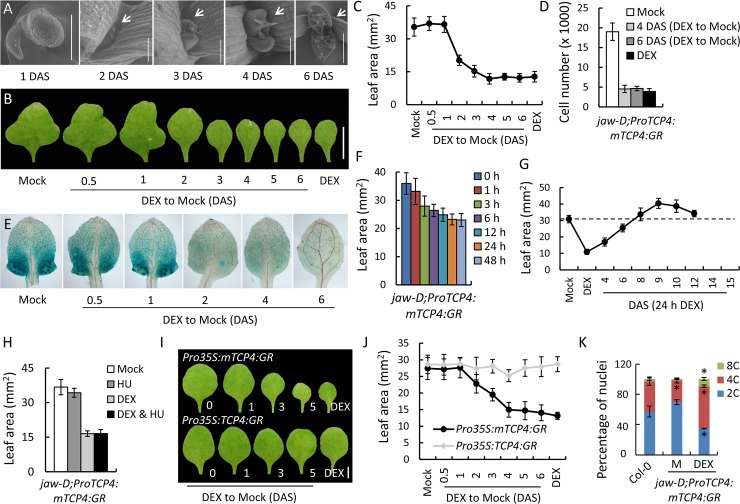
TCP4 irreversibly commits the proliferating cells of leaf primordia to differentiation.(A) Scanning electron micrographs of jaw-D;ProTCP4:mTCP4:GR seedlings after indicated DAS. A germinated seed (1 DAS) and the meristematic region of seedlings are shown. Scale bars, 500 μm (1, 6 DAS) and 100 μm (2, 3, 4 DAS). (B) Mature first leaf (29 DAS) of jaw-D;ProTCP4:mTCP4:GR seedlings grown in the presence of 12 μM dexamethasone for the indicated DAS and then shifted to medium without dexamethasone. Leaves grown in continuous absence (Mock) or presence (DEX) of dexamethasone are shown as controls. Scale bar, 5 mm. (C) Average size of leaves shown in (B). N, 12–15 leaves. (D) Number of pavement cells in leaves shown in (B). (E) GUS reporter analysis of first leaf from 8-day old jaw-D;ProTCP4:mTCP4:GR X ProCyclinD3;2:GUS seedlings grown in the presence of dexamethasone for the indicated DAS and then shifted to medium that lacks dexamethasone. Mock indicates seedlings grown without dexamethasone. (F) Average area of mature first leaves (N, 12–15) of jaw-D;ProTCP4:mTCP4:GR seedlings treated with 12 μM dexamethasone for indicated durations at 4 DAS. (G) Average area (N = 10–15) of mature first leaves of jaw-D;ProTCP4:mTCP4:GR seedlings treated with 12 μM dexamethasone for 24 hours at indicated DAS. Mock indicates no treatment; DEX, continuous dexamethasone treatment. (H) Average area of mature first leaves from jaw-D;ProTCP4:mTCP4:GR seedlings treated with 2 mM hydroxyurea (HU) and/or 12 μM dexamethasone (DEX) for 36 hours at 3 DAS. Mock indicates no treatment. N, 8–12 leaves. (I) and (J) Mature first leaf (I) from seedlings grown in the presence of dexamethasone for the indicated DAS and then shifted to medium that lacks dexamethasone, and their average size (J). N, 10–15 leaves. (K) Nuclear ploidy analysis of first leaf pair from 8-day old seedlings grown in the absence (Col-0, M) or presence (DEX) of 12 μM dexamethasone. Averages from biological triplicates are shown. Error bars indicate SD. * indicates p <0.05. Unpaired Student’s t-test was used.